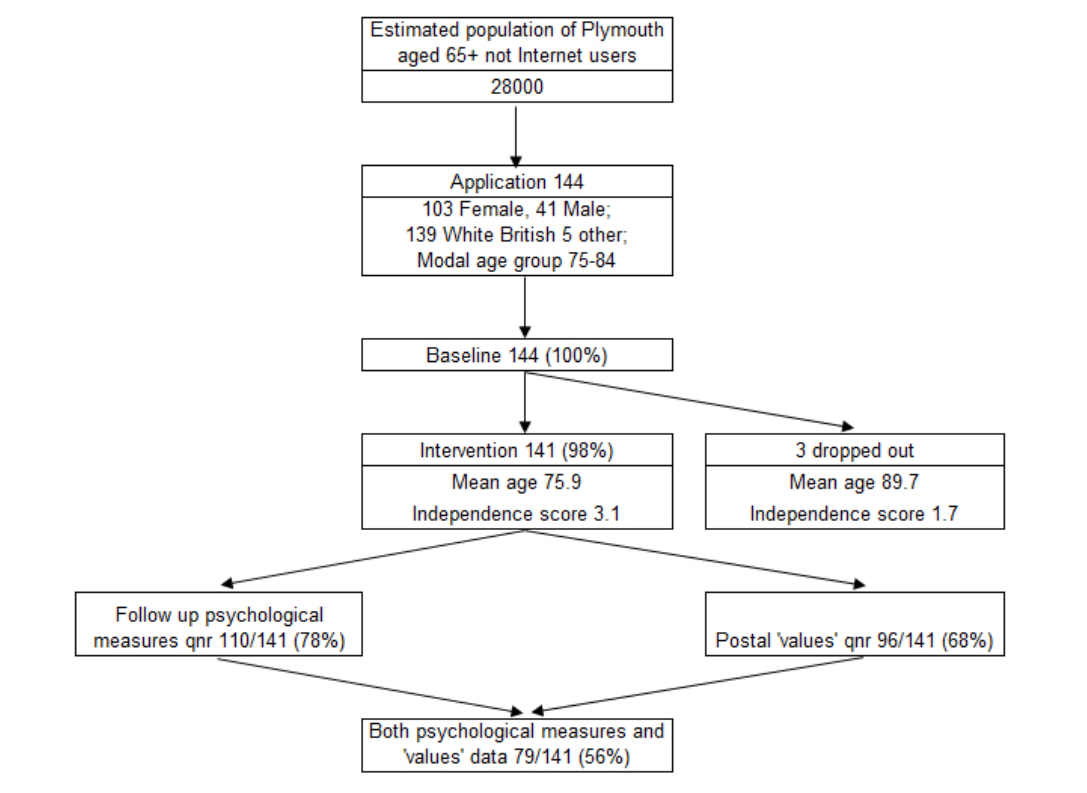
Figure 1. Participant recruitment and